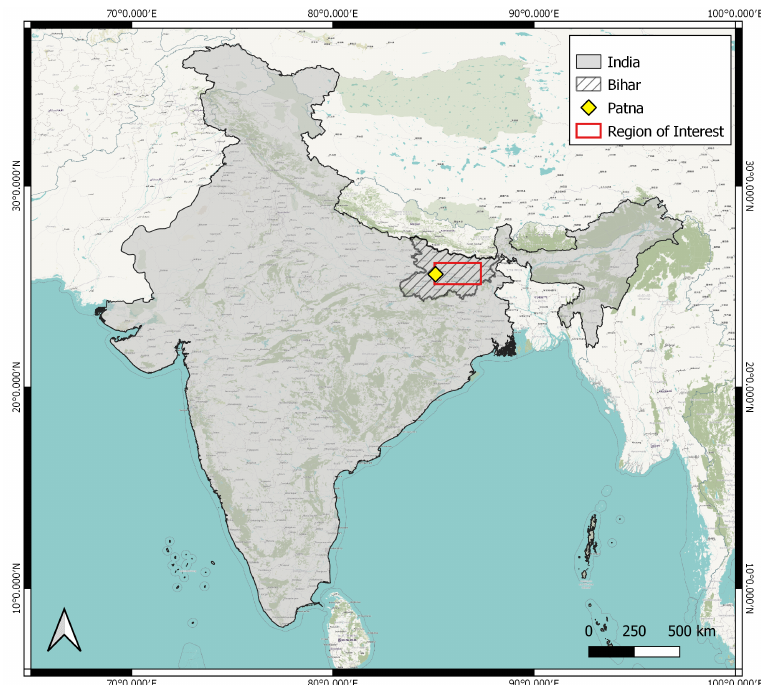
Figure 2. Case II: ROI near the city Patna in the State of Bihar, India (Spatial reference system EPSG:4326